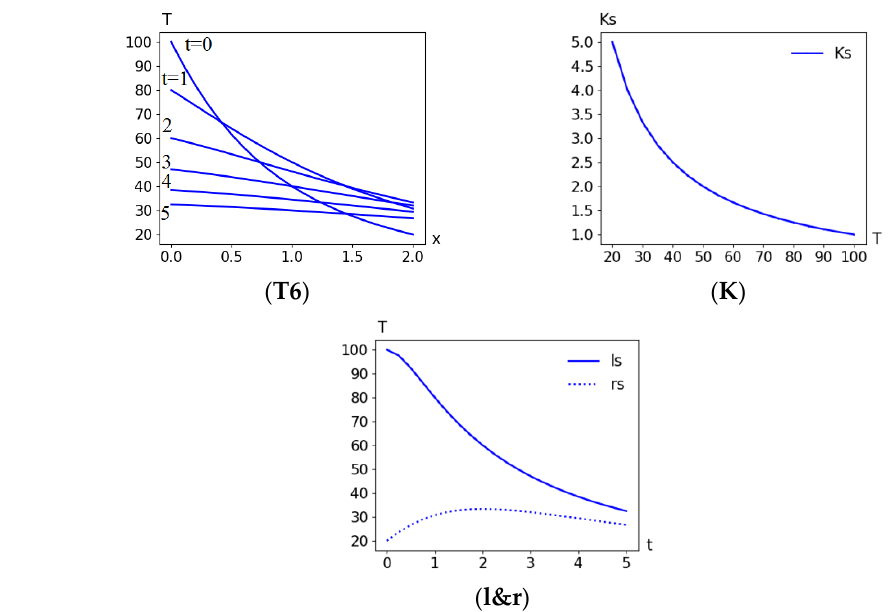
Figure 1. Functions of the exact solution: ( T ) contour lines of Ts ( x,t ); ( T6 ) 6 time slices of Ts ( x,t ): Ts ( x ,0), Ts ( x ,1),..., Ts ( x ,5); ( K ) thermal conductivity K(T) ; ( φ ) initial condition φs ( t ); ( l&r ) left ls ( x ) and right rs(x) boundary conditions .